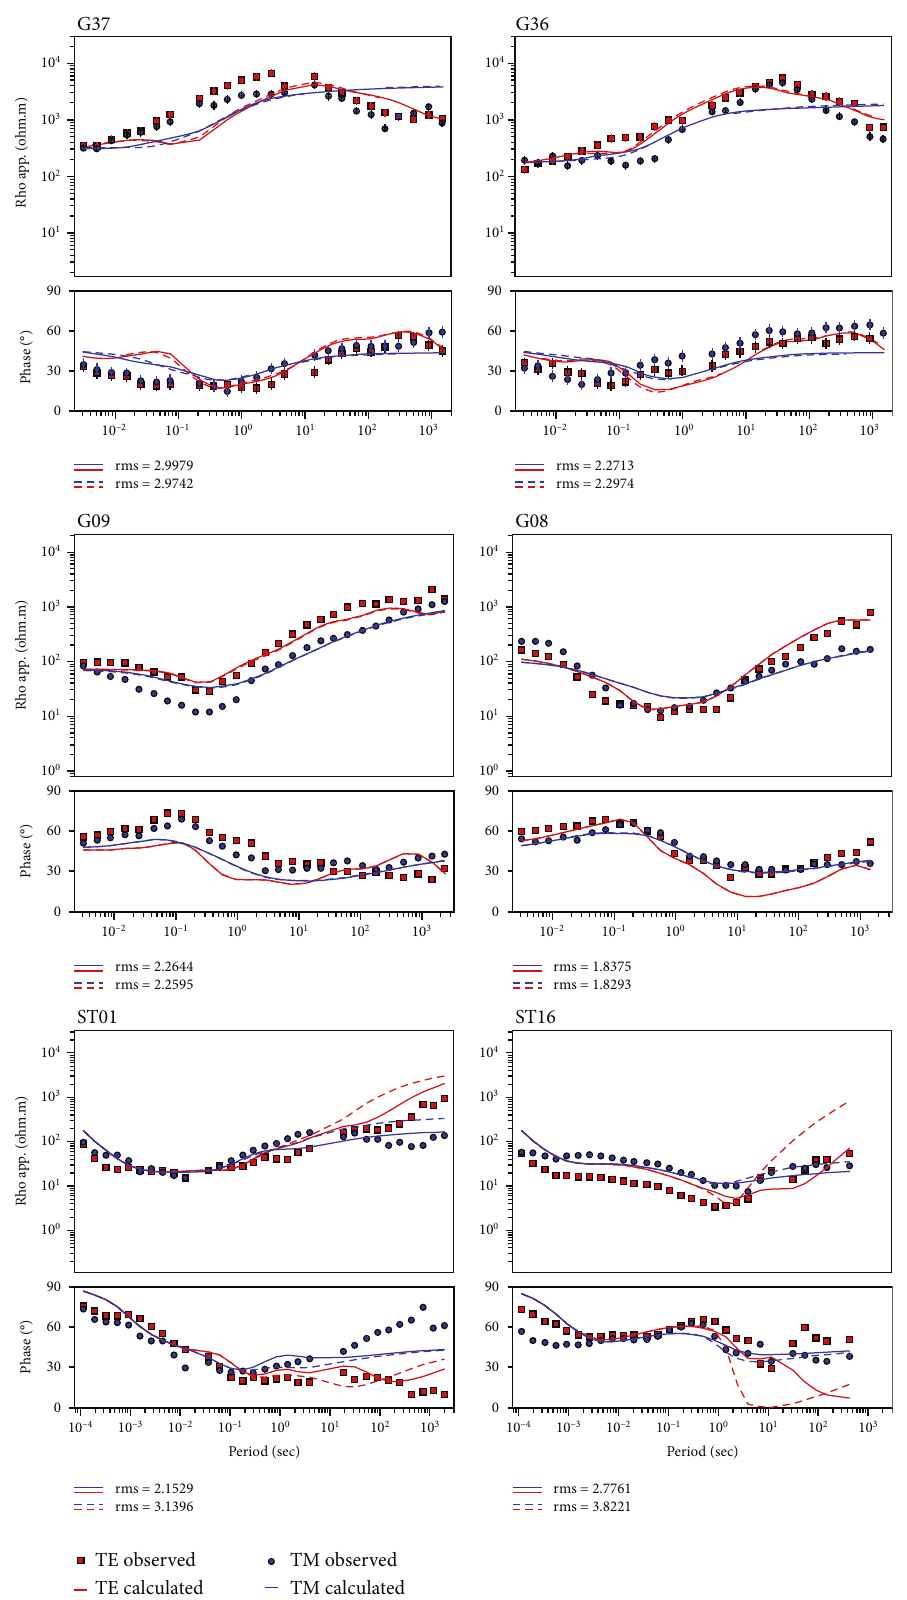
Figure 13: Comparison of the model response vs. data fi tting, before and after changing the resistivity values of the blocks tested, at stations G36, G37 (line C-C ′ ), G08, G09 (line D-D ′ ), ST01, and ST16 (line E-E ′